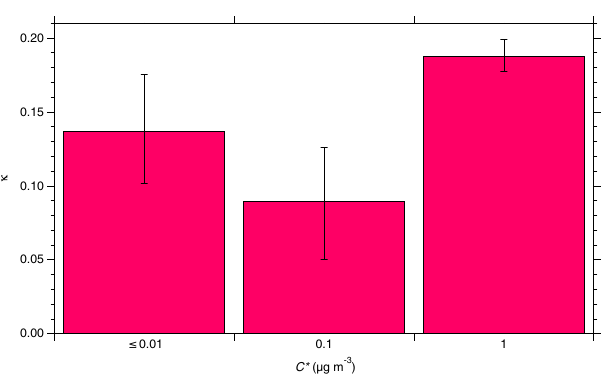
Figure 10. The κ distribution that resulted from solving Eq. (4) for TD temperatures greater than 50 ◦ C and the three lowest bins for Experiment 2. The error bars represent 1 standard deviation ob- tained by solving the equations at ± 1 standard deviation of the measured κ